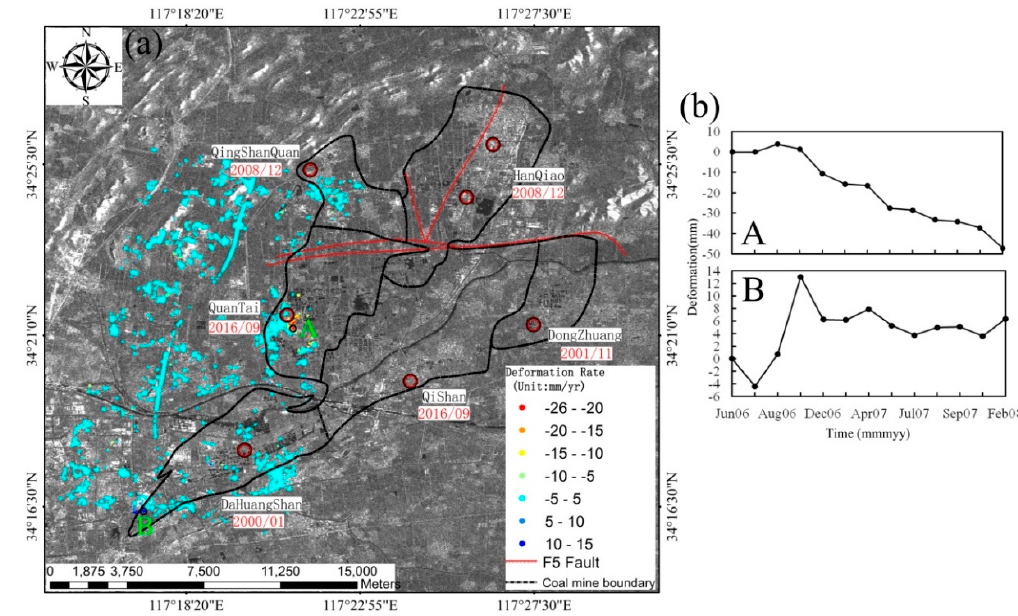
Figure 3. The LOS deformation from June 2006 to February 2008. ( a ) The LOS annual average deformation rate. The red-black circles show the locations of the main wells in the mining area. The black circles show the location of the pixels whose time-series are showed in ( b ), and the base map is the intensity image of ENVISAT obtained on 16 March 2010. ( b ) The LOS time-series deformation.